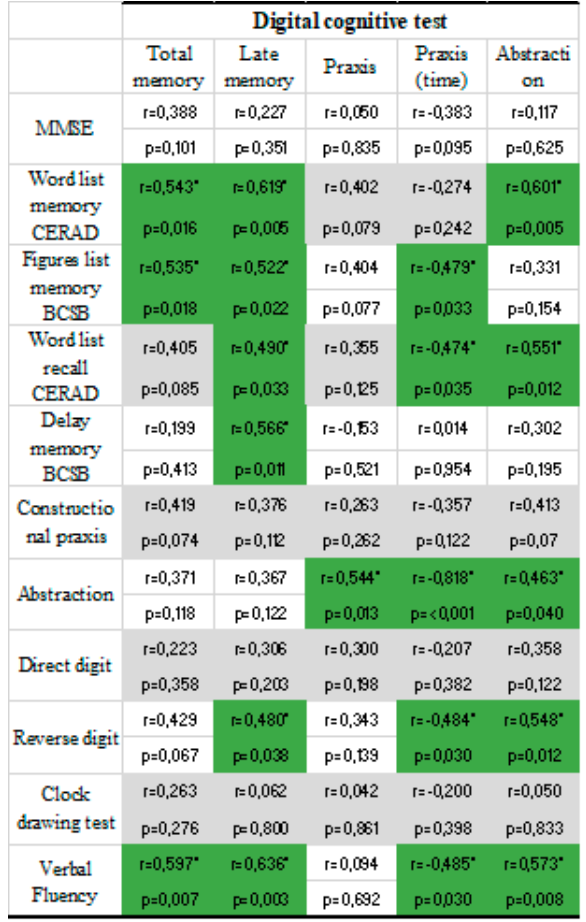
Fig. 8. Statistic convergence analysis of the second